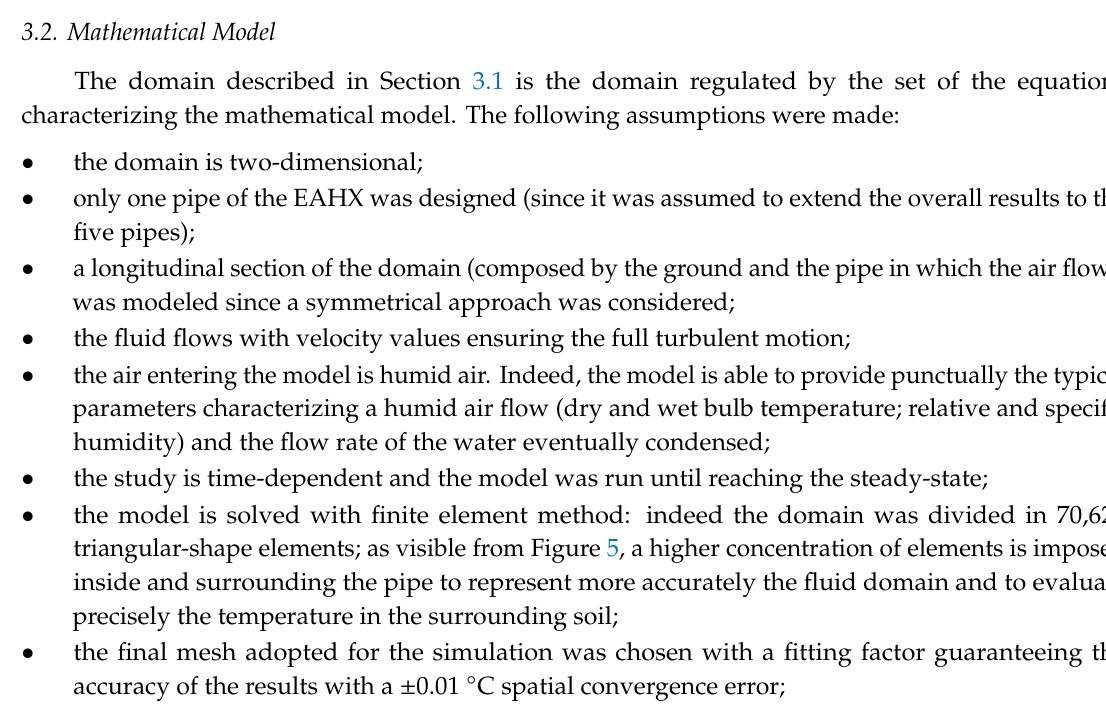
Figure 5. Computational mesh domain of the investigation on a single buried pipe of the EAHX.